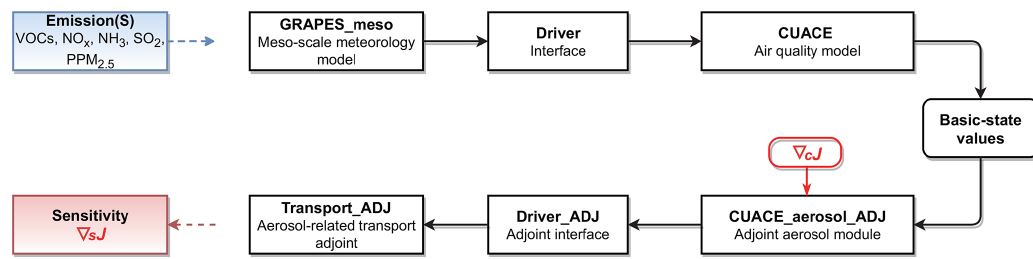
Figure 1. Running process of GRAPES–CUACE atmospheric chemistry model and its adjoint model.